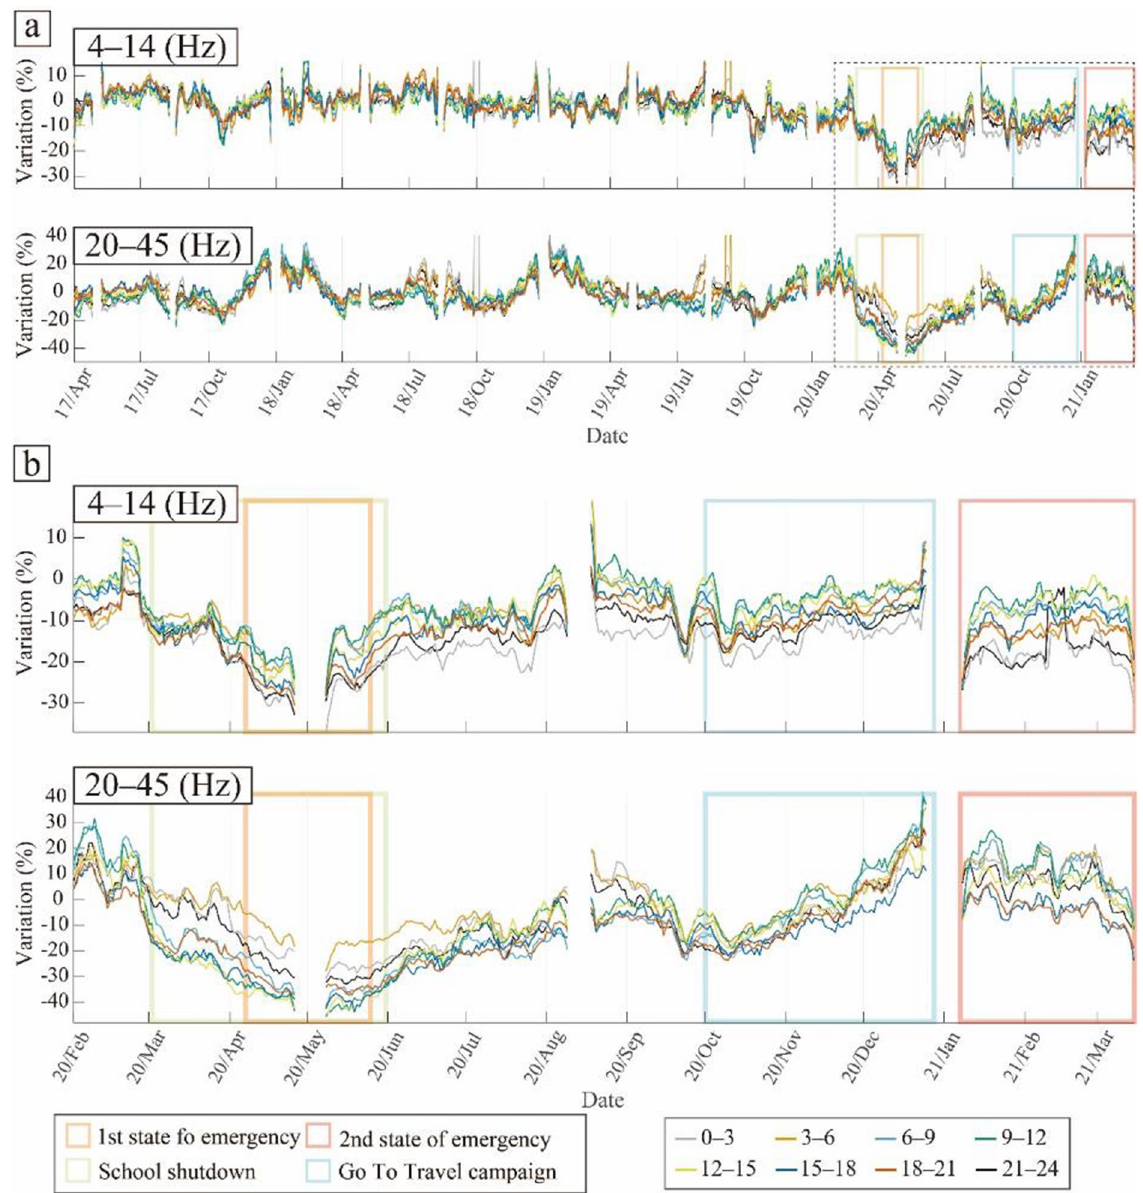
in the right bottom box. The orange and pink squares represent the periods of the first and second states of emergency in Tokyo, respectively; the green square represents the period of school closures; and the light blue square represents the period of the Go To Travel